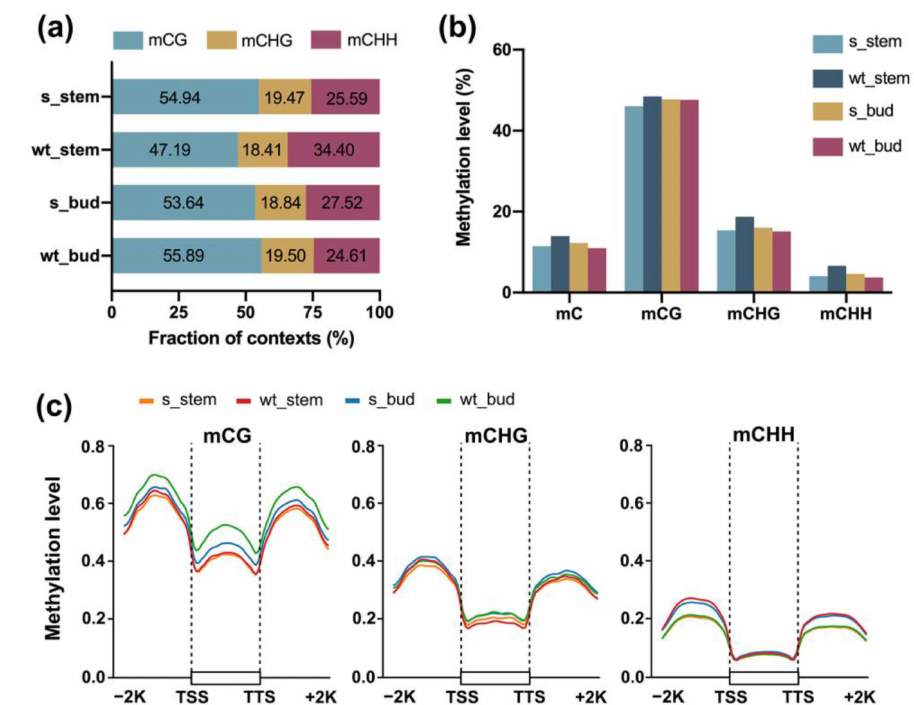
Figure 2. DNA methylation landscape of wild-type and BrCHR39 -silenced plants. ( a ) Proportion of mCG, mCHG, and mCHH contexts in the stem and bud of wild-type and transgenic plants. ( b ) The DNA methylation levels of mCG, mCHG, and mCHH contexts of the stem and bud in wild-type and transgenic plans. ( c ) Distribution of DNA methylation levels for all samples in different genomic regions. TSS, transcription start site; TTS, transcription termination site.